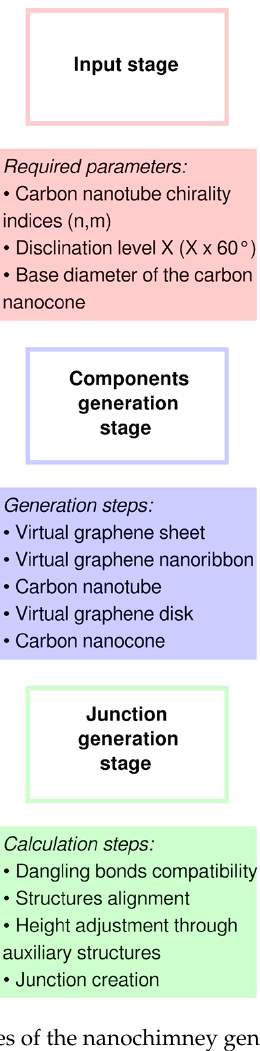
Figure 1. The stages of the nanochimney generation algorithm.